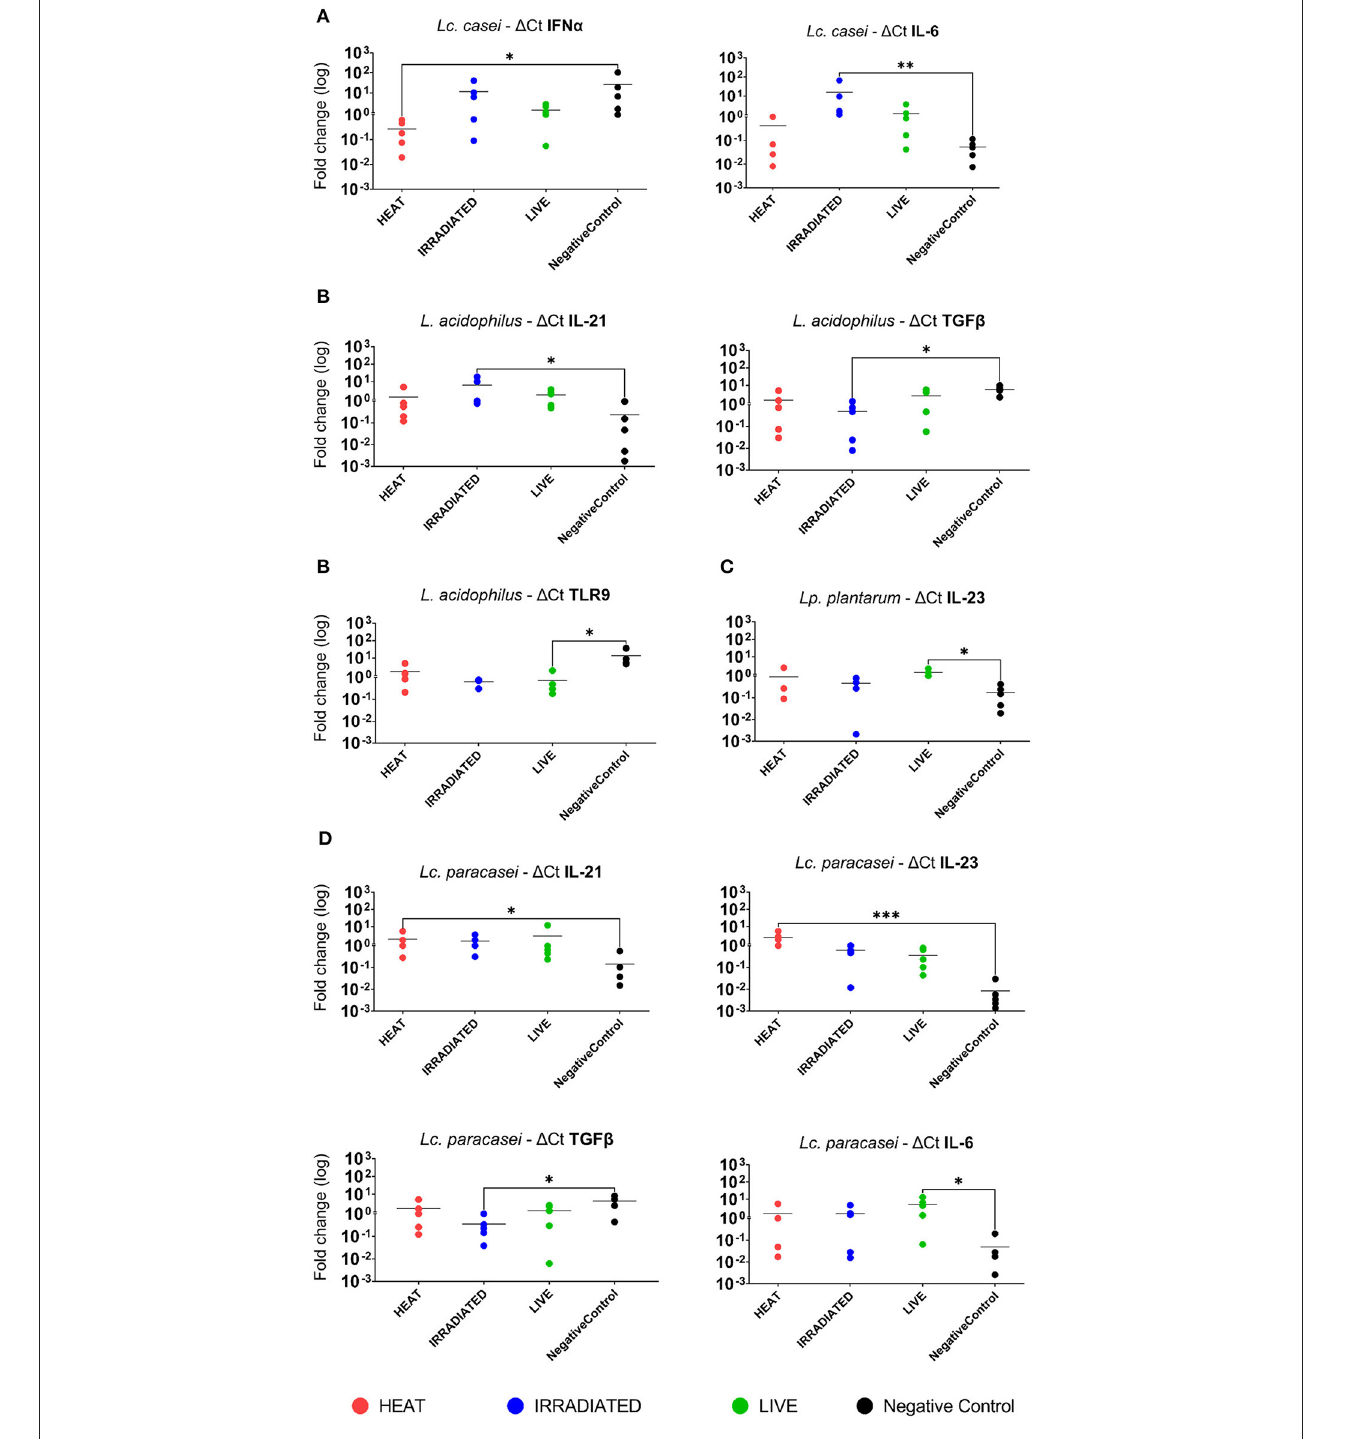
FIGURE 4 | Statistically significant fold change differences in gene expression of immune markers in porcine PBMCs. Logarithmic fold change difference in gene expression comparing individual values (dots) of each animal ( n = 5) where blood was collected to isolate PBMCs. Here, we report gene expression showing statistical significance highlighted by one-way ANOVA analysis, where * ( P ≤ 005), ** ( P ≤ 0.01), and *** ( P ≤ 0.001) were used to express the degree of significance. Gene expression analysis was performed by comparing unstimulated PBMCs (negative control; black dot) with heat-treated (red dot), gamma-irradiated (blue dot), or live (green dot) Lacticaseibacillus casei (A) , Lactobacillus acidophilus (B) , Lactiplantibacillus plantarum (C) , and Lacticaseibacillus paracasei (D) .